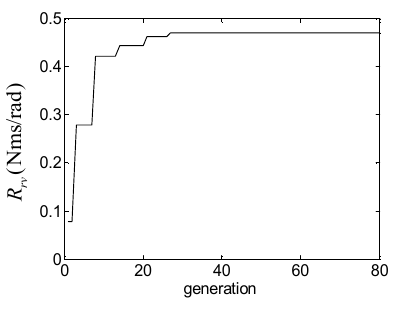
Figure 6. Identification of R rv .